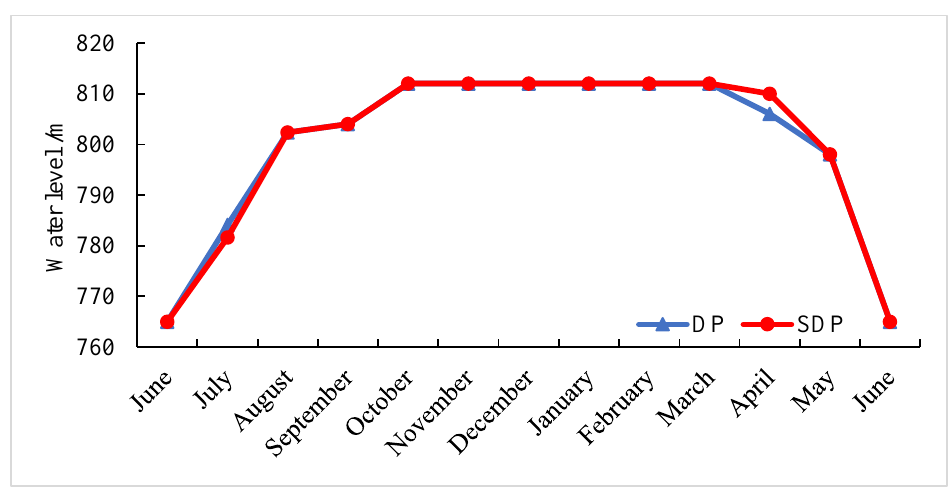
Figure 12. Results for operation of the NZD hydropower plant based on DP and SDP.